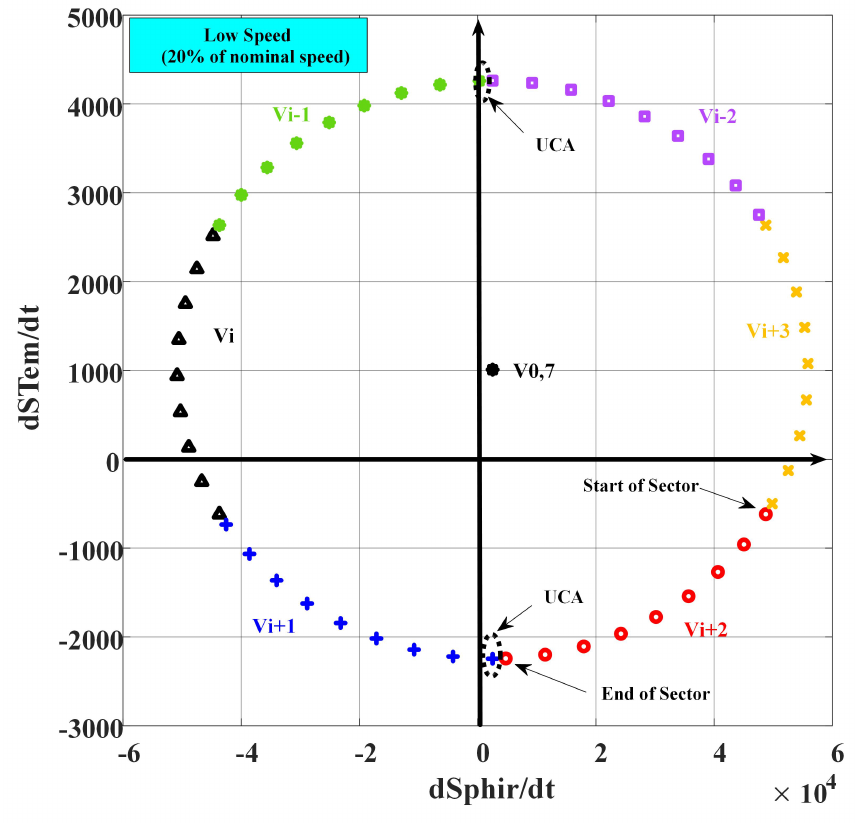
Figure 2. Values of dS Φ r and dS Tem for low positive speed ( 20% ω n )